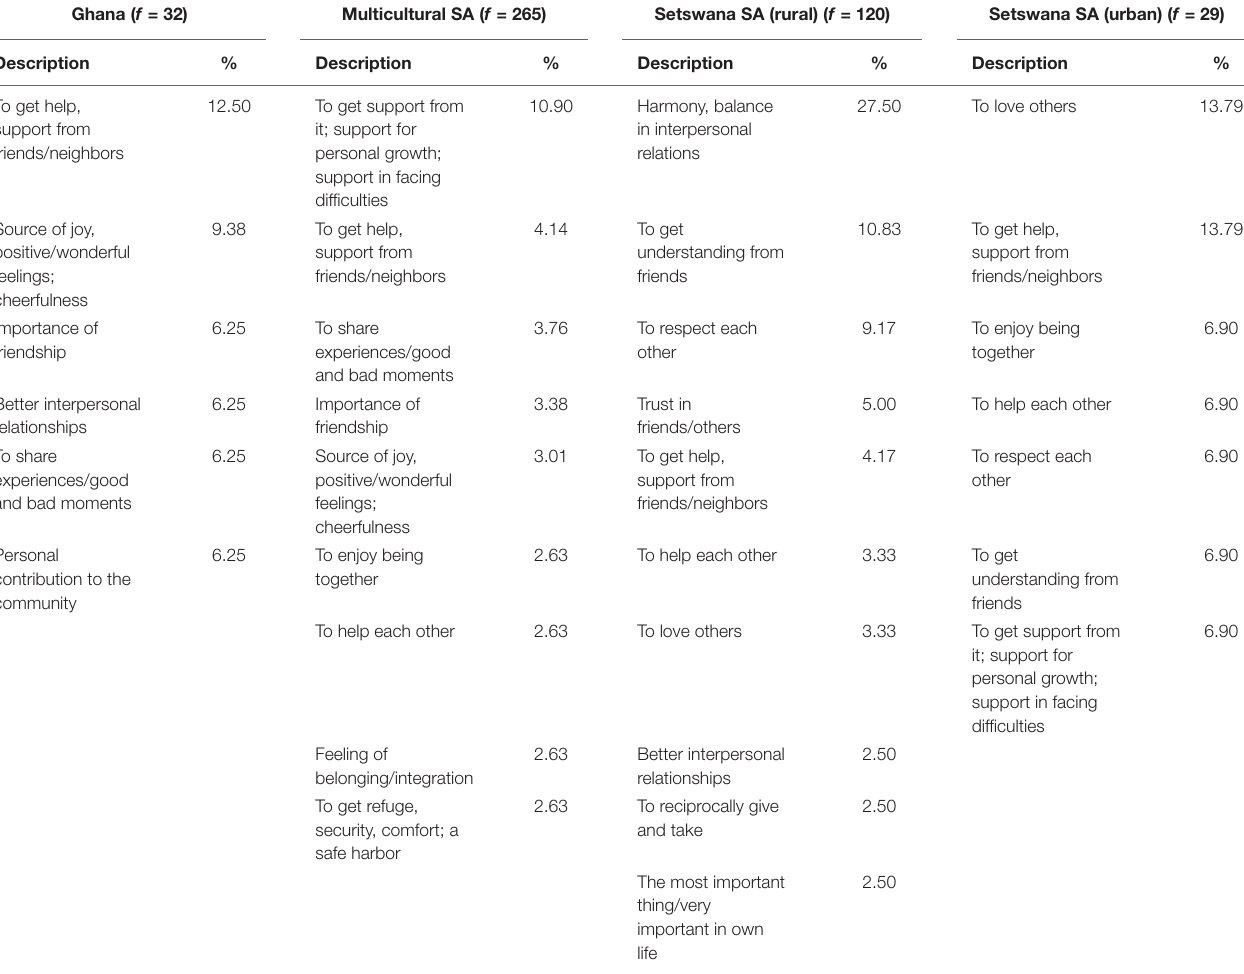
TABLE 6 | Percentages of the most frequent codes in the motivations for meaning sources in the interpersonal relations domain of life. Ghana ( f =